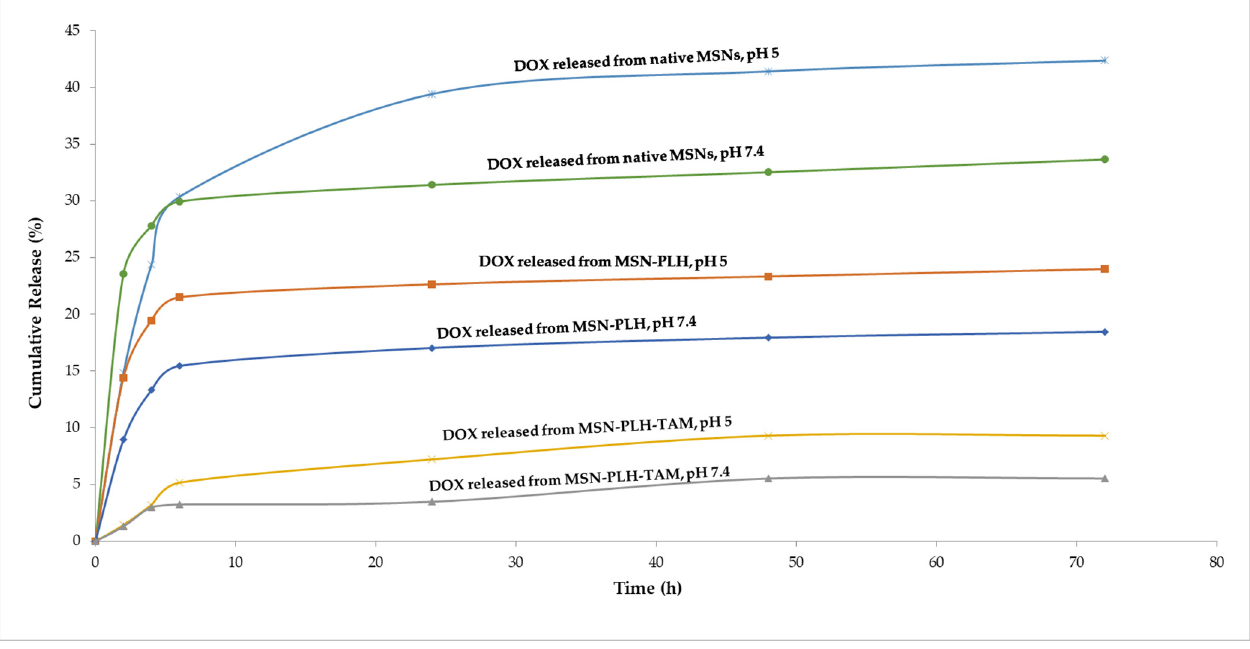
Figure 5. In vitro cumulative release profile of DOX@MSN, DOX@MSN-PLH and DOX@MSN-PLH-TAM over 72 h.